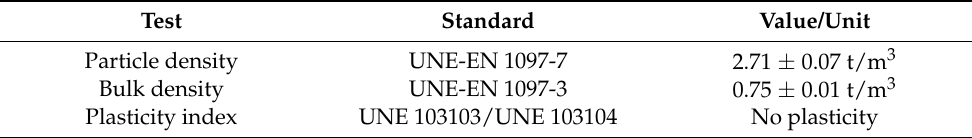
Figure 3. Images of ladle furnace slag with scanning electron microscope at different magnifications in the secondary option. ( a ) 3000×; ( b ) 12,000×.